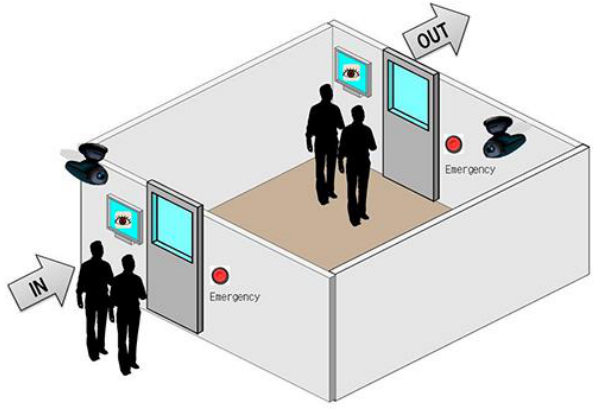
Figure 8. Example two-man rule control system at the Rokkasho reprocessing plant [16] .